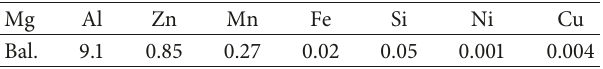
Table 1: Chemical compounds (wt.